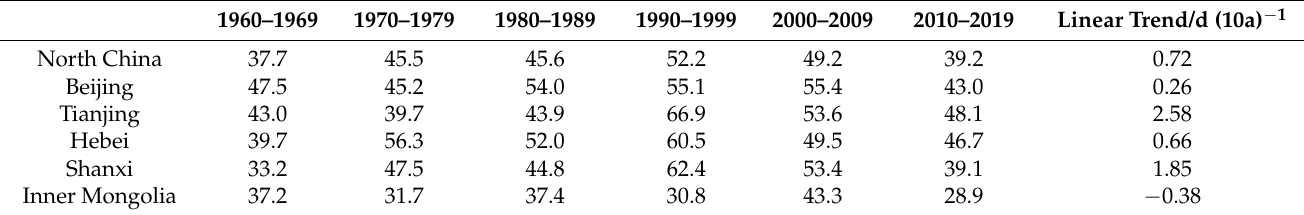
Table 3. Decadal average and linear trend rate of mid drought and above days for North China.